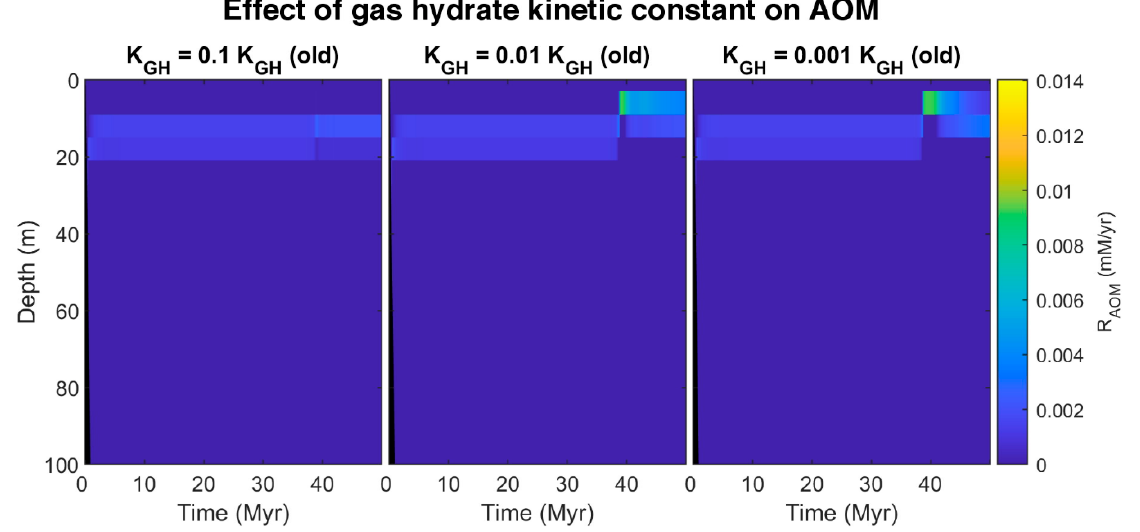
Figure 9. Simulated rate profile of AOM at different gas hydrate kinetic constant (0–100 mbsf).